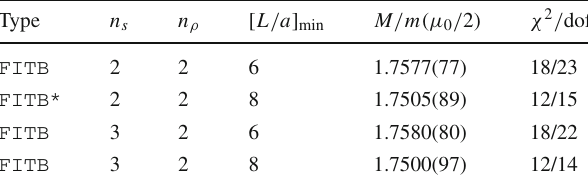
Table 2 Various fits of the anomalous dimension and results for M / m (μ 0 / 2 ) , see Sect.